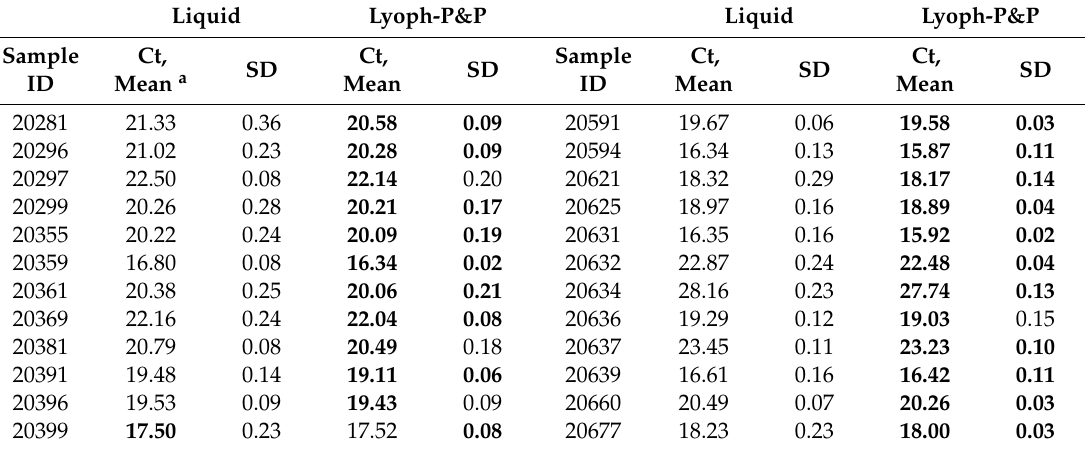
Table 8. Sensitivity of Lyoph-P&P and extemporaneously prepared liquid formulation for CHIKV RNA detection. Liquid Lyoph-P&P Liquid Lyoph-P&P Sample ID